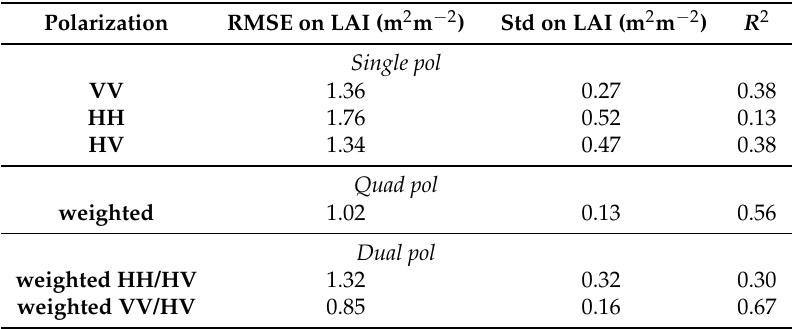
Table 3. The performance of the retrieval with single polarization and after Bayesian LAI recalculation. With all three polarizations, the RMSE on LAI estimation decreased by 0.32 m 2 /m 2 , whereas considering only the VV-HV polarizations, the RMSE drops by 0.49 m 2 /m 2 . Polarization RMSE on LAI (m 2 m − 2